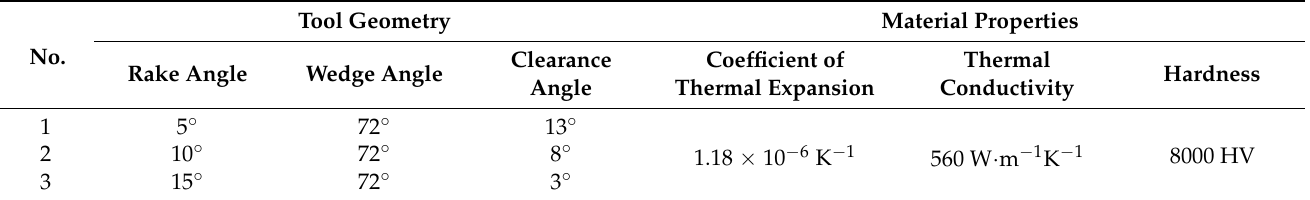
Table 2. Parameters of cutting tools.